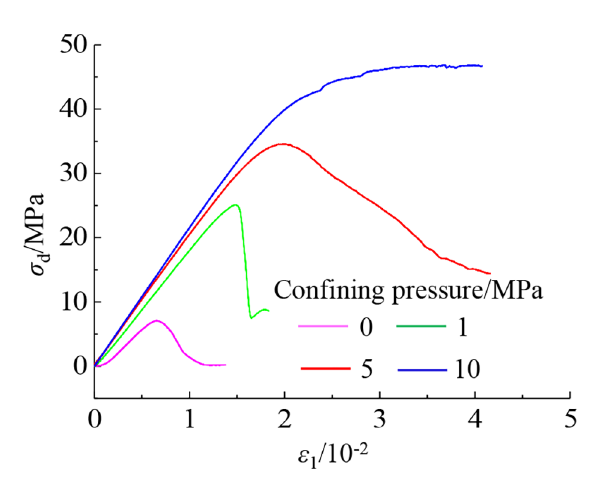
Fig. 14 Numerical strength results of jointed coal subjected to triaxial compression with different confining pressures. Notes: σ d refers to the difference between axial stress and confining pressure; ε 1 denotes the axial strain